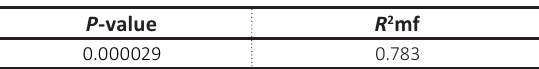
Table 5. Overall significance test and evaluation